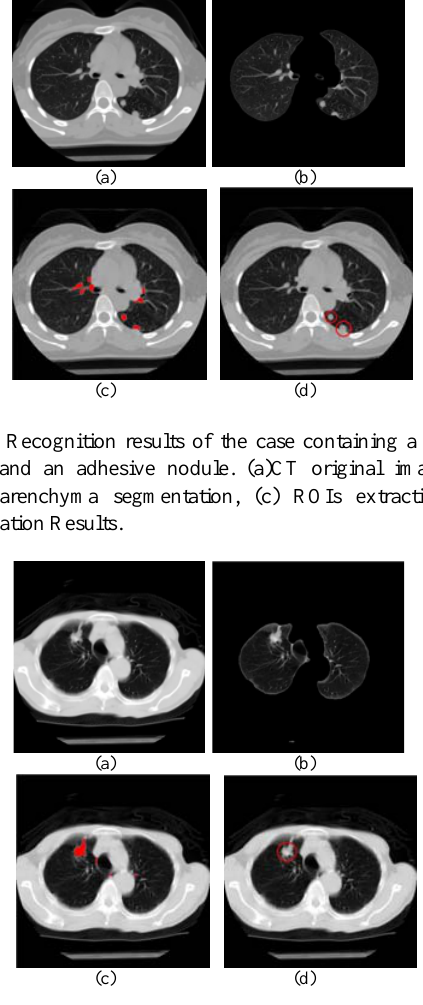
Fig. 12. Recognition results of the case containing an adhesive nodule. (a) CT original image, (b) Lung parenchyma segmentation, (c) ROIs extraction, (d)Classification